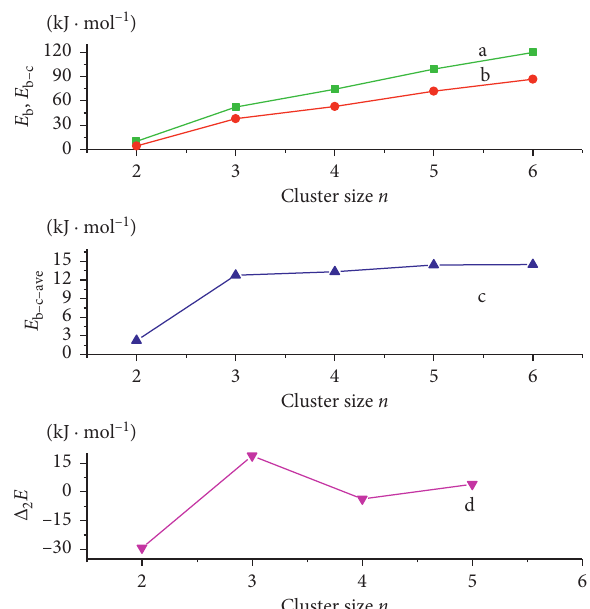
Figure 2: The uncorrected binding energies E b (a), corrected binding energies E b-c (b), average corrected binding energy E b-c- ave (c), and the second-order energy difference Δ 2 E (d) of the asymmetric clusters (CH 3 FBN 3 ) n ( n � 1 − 6) versus the cluster size n